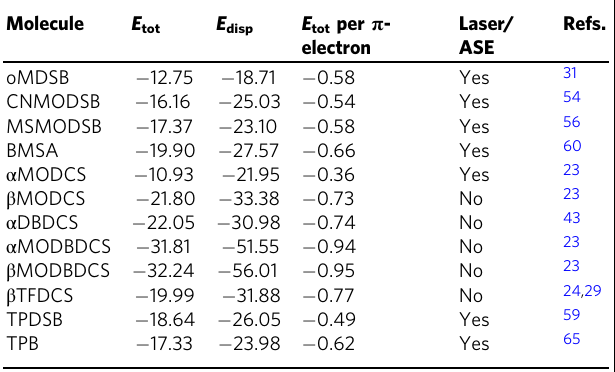
Table 2 π – π interaction energies and dispersion energies of all investigated π -stacking materials a .